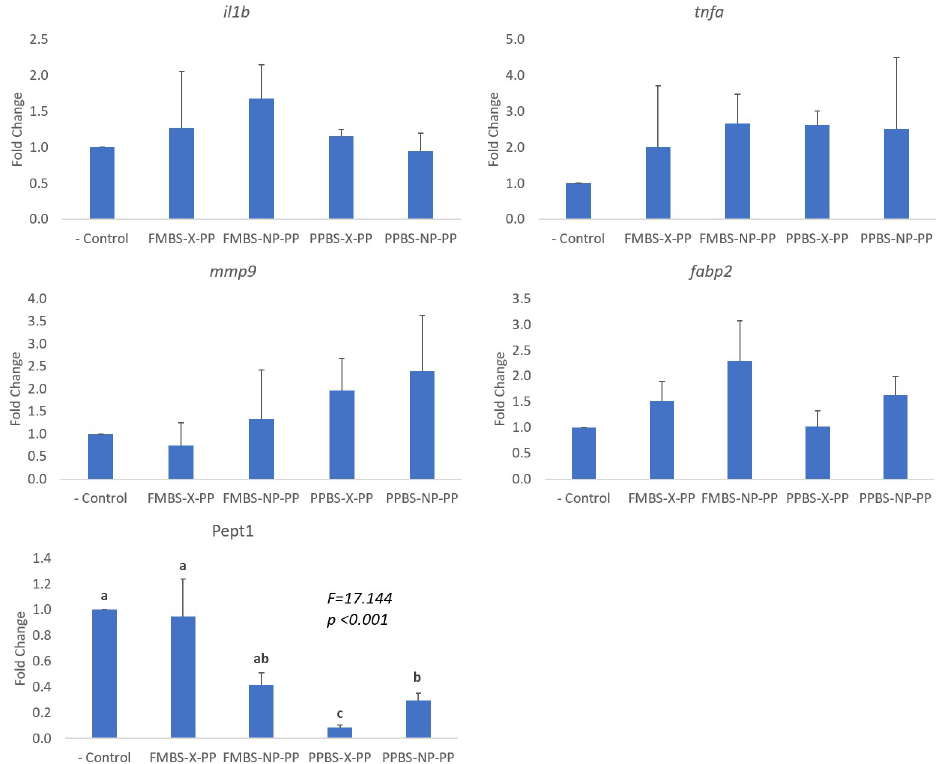
Fig 2. Intestinal gene expression. Relative gene expression of the group is represented as a fold change relative to the negative control group (fold change = 1). Values provided are mean fold change + S.E.M (standard error of the mean). Results of One-way ANOVA and Tukey test are shown on graphs when significant. Significant differences (p < 0.05) between groups are represented by different letters.